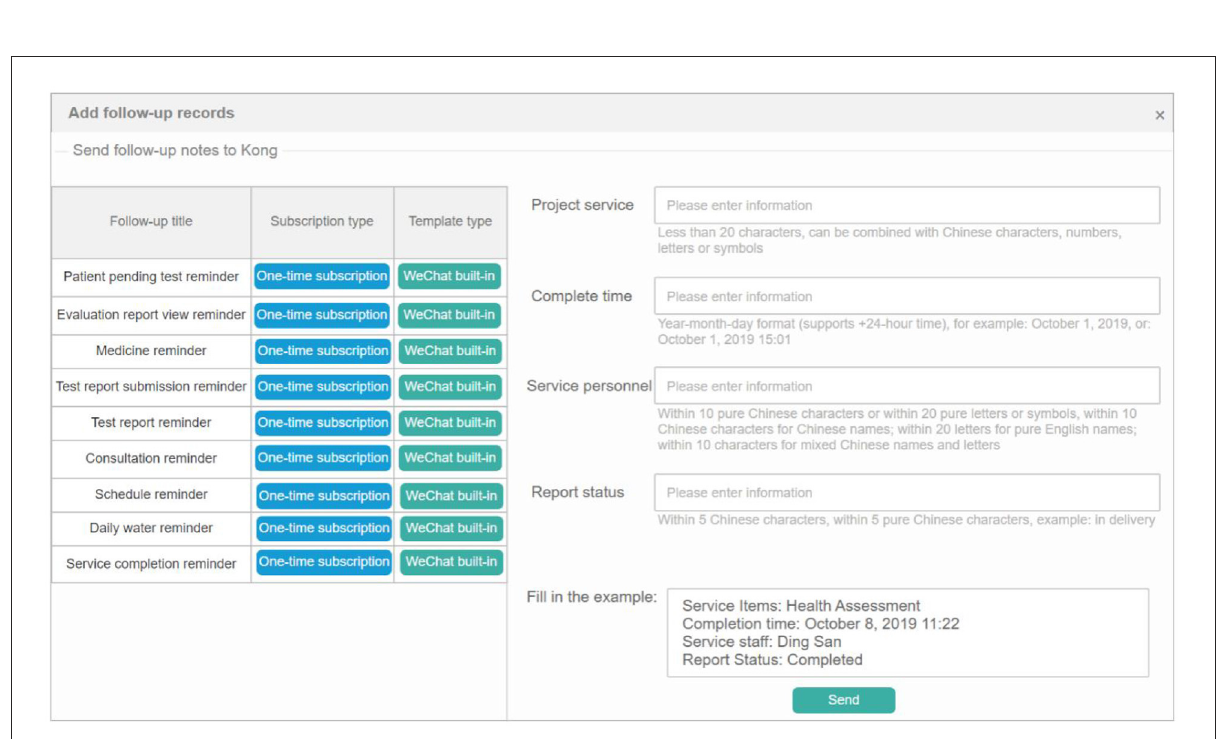
FIGURE11 Follow-up record